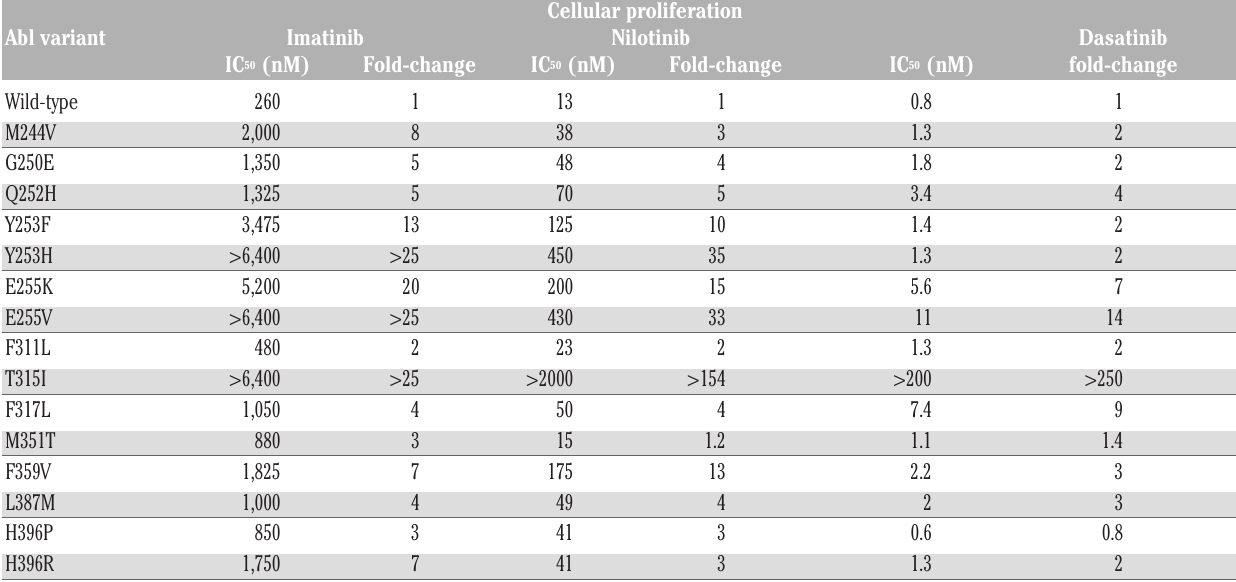
Table 1. Comparison between imatinib, dasatinib and nilotinib IC 50 values obtained in Ba/F3 cellular proliferation assays. Adapted from [8]. Cellular